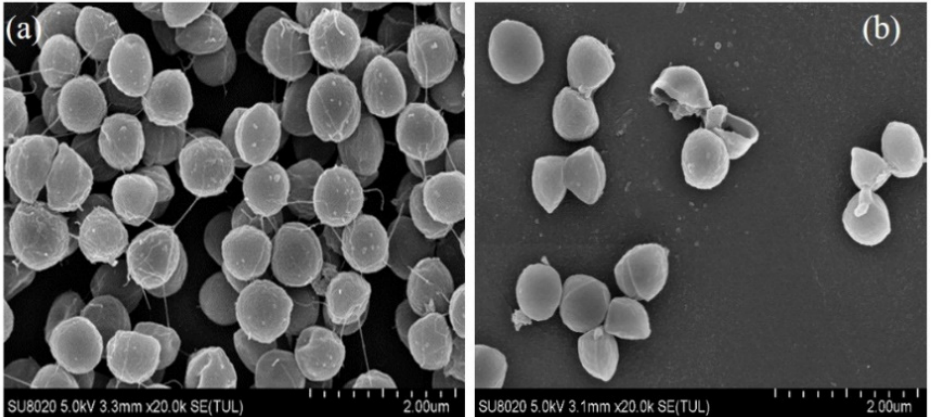
Figure 5. SEM images of S. saprophyticus biofilm. ( a ) Bacteria control group, lots of bacterial cells aggregated together and encased by extracellular polymeric substances. ( b ) Biofilm inhibition by PDI treatment, a small number of bacterial aggregates.